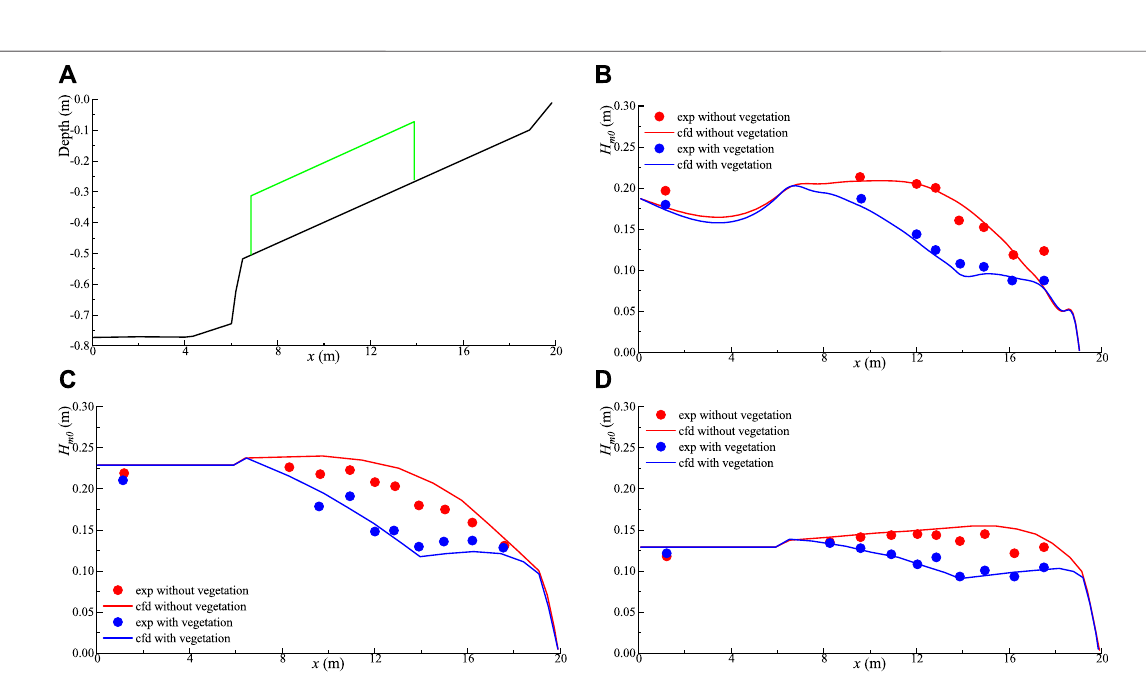
Frontiers in Environmental Science |